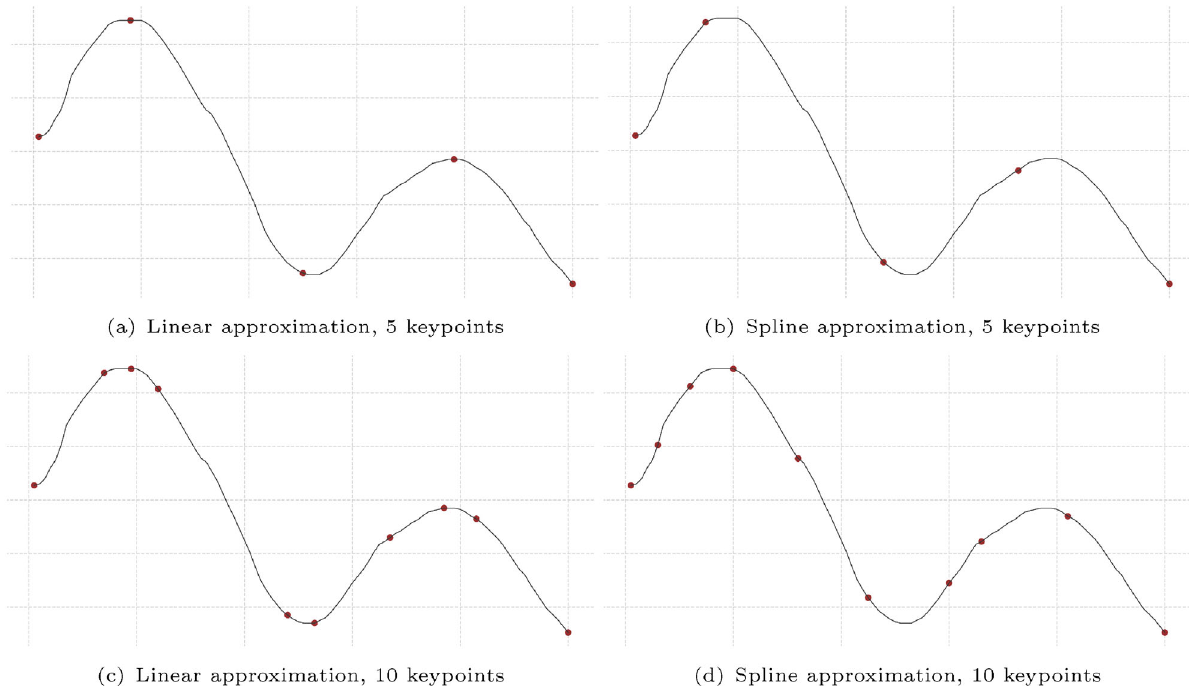
Fig. 6 An example of how keypoints selected using a spline approximation function do not always provide useful controls for editing. Notice how, when using the linear approximation (a, c), the keypoints tend to be located near extrema and inflection points of the curve, at least more so than in the case of spline approximation (b, d). Although harder to quantify, through informal discussion with artists we theorize that this effect extends to the problem of selecting keyframes for higher dimensional curves. See Section 3.3 for further